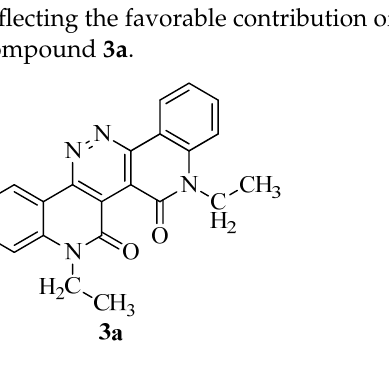
Figure 3. The assigned structure of compound 3a.